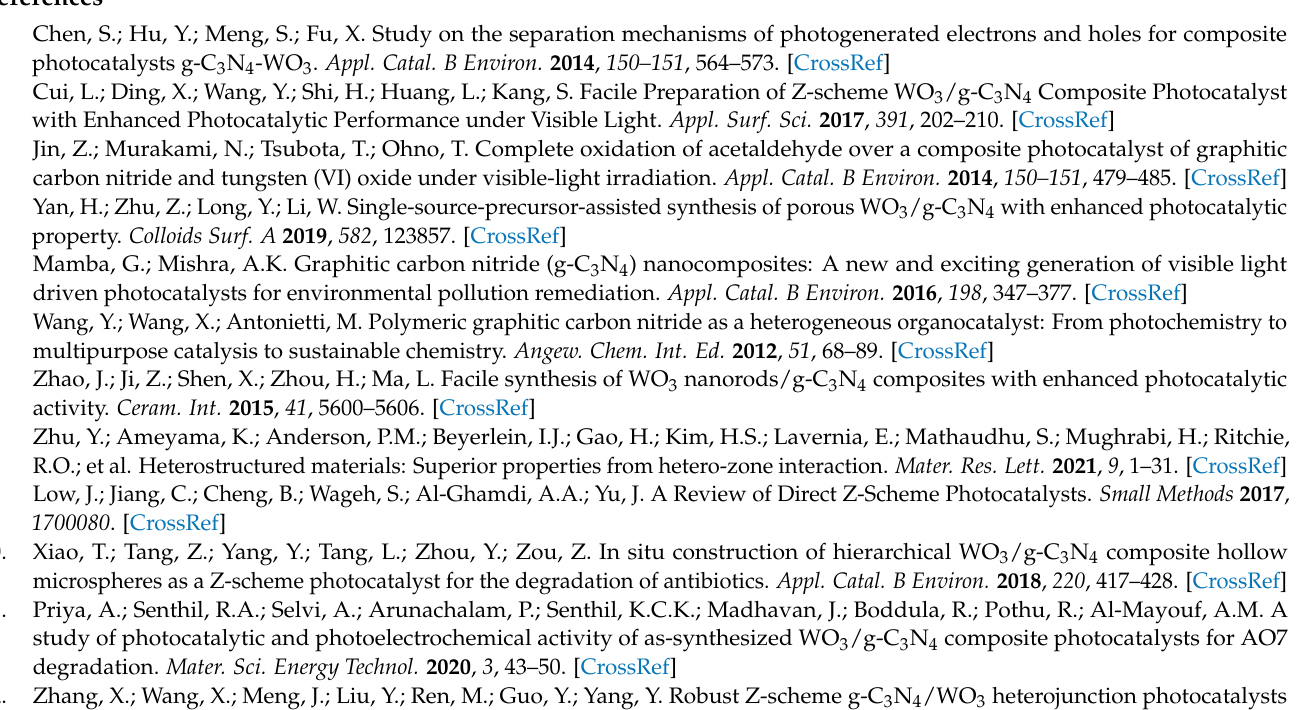
catalyst. Figure S5: SEM image of catalyst 6.5%WCN after three photocatalytic cycles. Figure S6: FT-IR spectra of composite material 6.5%WCN after the third photocatalytic